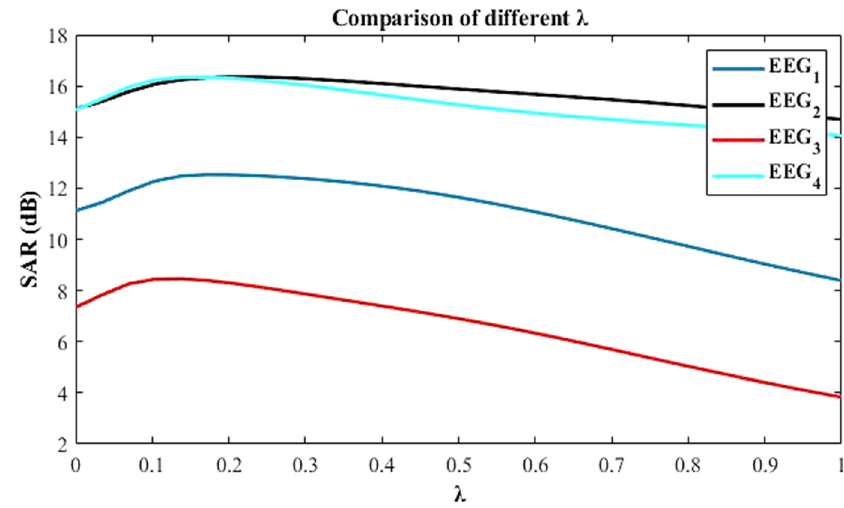
Figure 5. SAR improvements for different values of λ at P = 4 and M = 50.